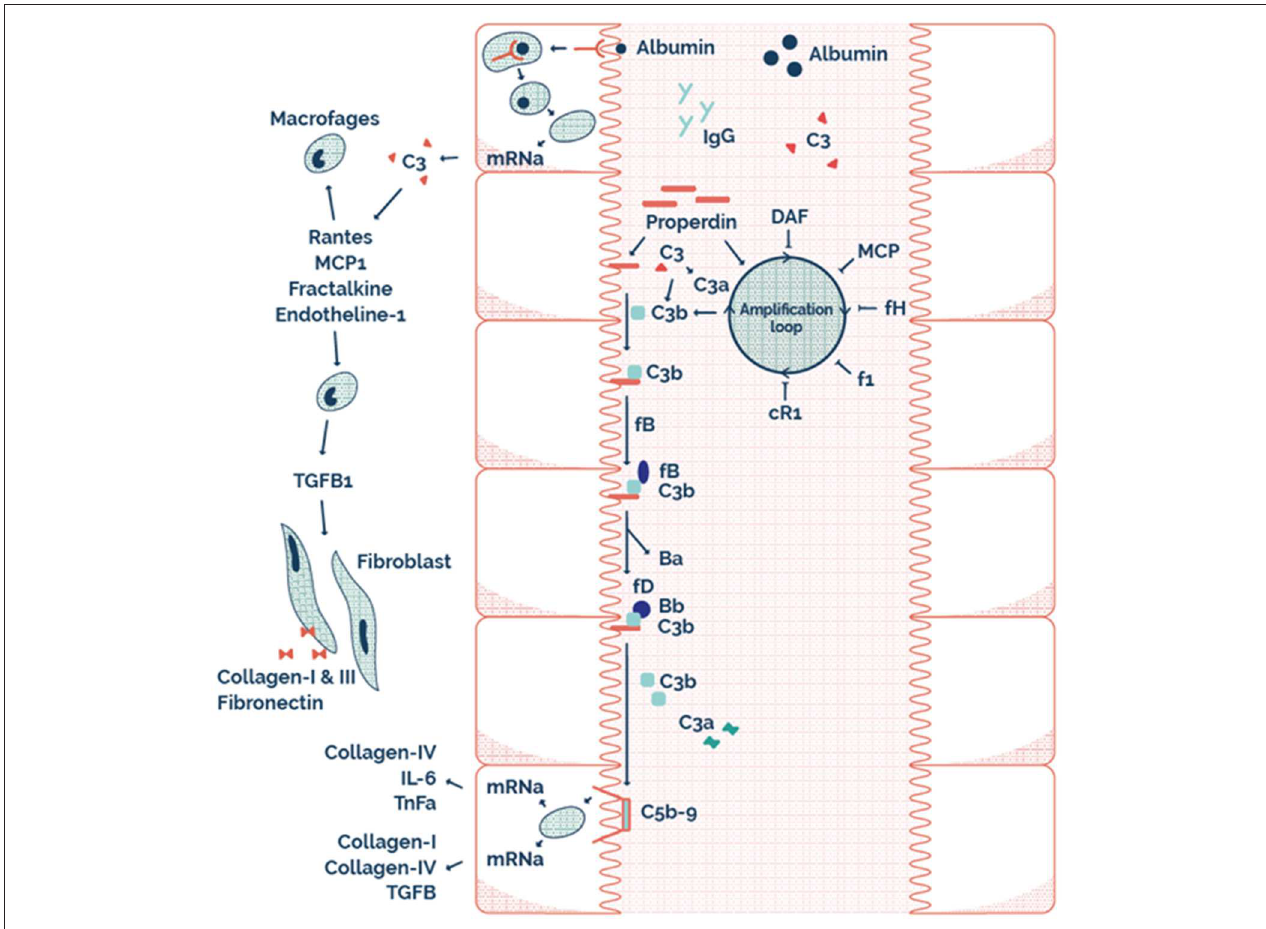
FIGURE 4 | The possible mechanism on a tubular level illustrating tubular alternative pathway complement activation via properdin as pattern recognition